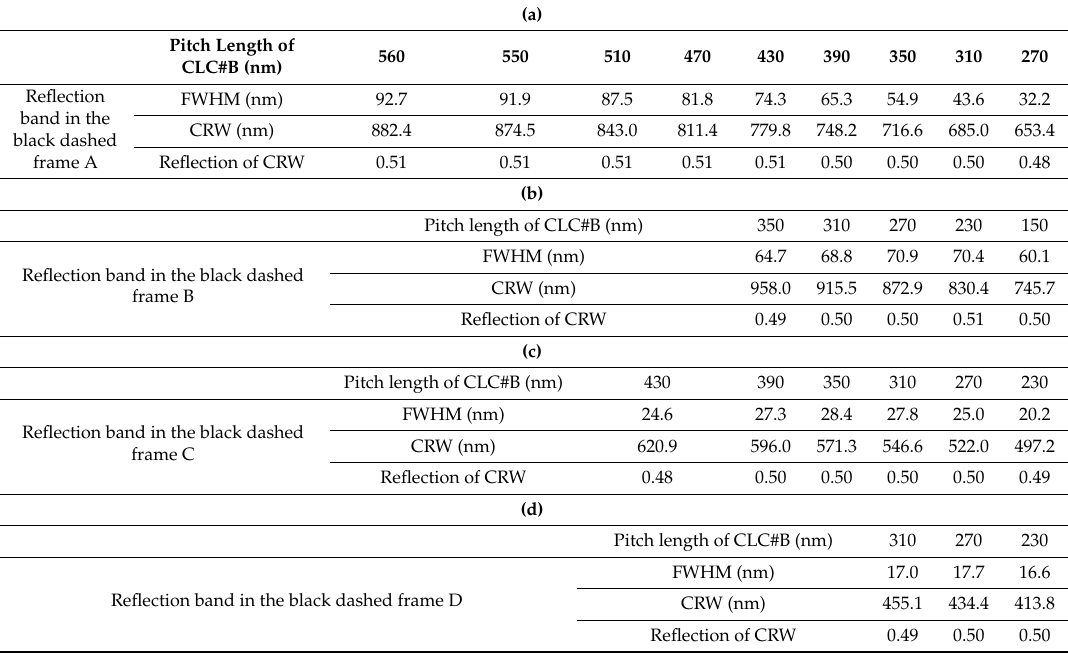
Table 1. Values of FWHM, CRW, and reflection of CRW of reflection bands with reflections of CRW close to 0.5 ( > 0.48) in the black dashed frames ( a ) A, ( b ) B, ( c ) C, and ( d ) D plotted in Figure 2.